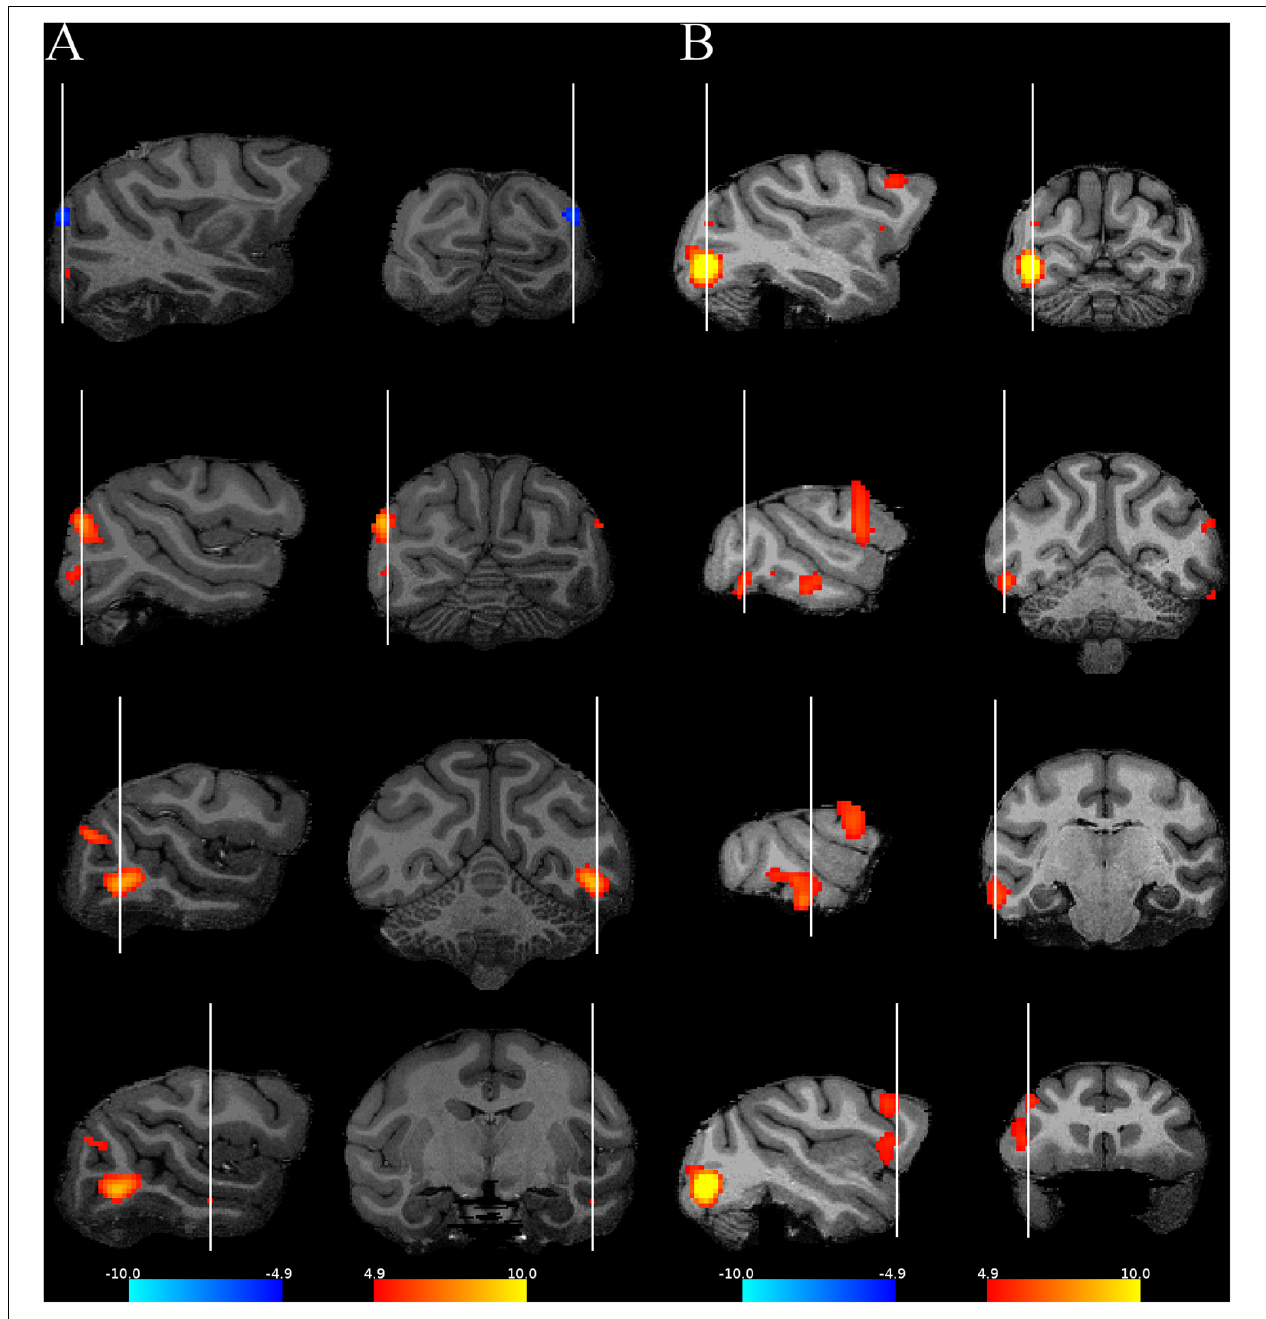
FIGURE 3 | Activations when contrasting the regular and the random sequences. Four representative slices are shown for each monkey using their own anatomy. The red activations correspond to the contrast random–regular sequence, while the blue ones correspond to the opposite contrast. (A) M1, (B) M2. The same conventions as in Figure 2